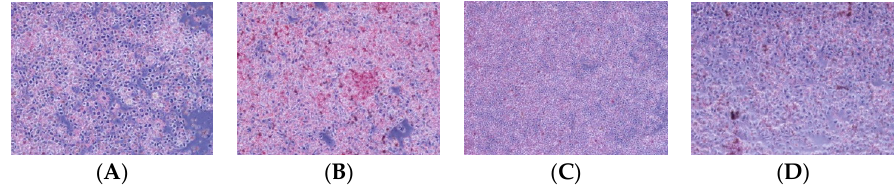
Figure 2. Oil Red O staining. Lipid accumulation in HepG2 cells induced by FFAs for 24 h. Lipid droplets in HepG2 cells was observed by microscope (400×): the control cells treated with only 5% BSA ( A ); cells treated with FFAs for 24 h ( B ); cells pretreated with FFAs for 24 h and cultured with Gardenoside 10 µM for 24 h ( C ); cells pretreated with FFAs for 24 h and cultured with Gardenoside 20 µM for 24 h ( D ).